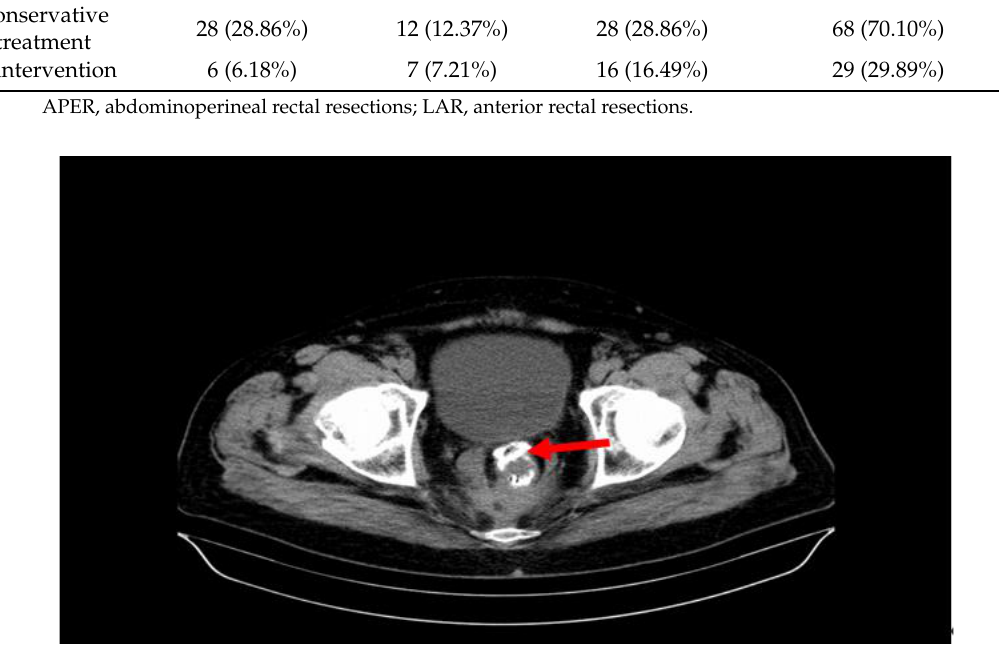
Figure 1. Anterior colorectal anastomotic fistula (red arrow) after laparoscopic low anterior resection (LAR). The image shows the anastomosis clips arranged in a circle.